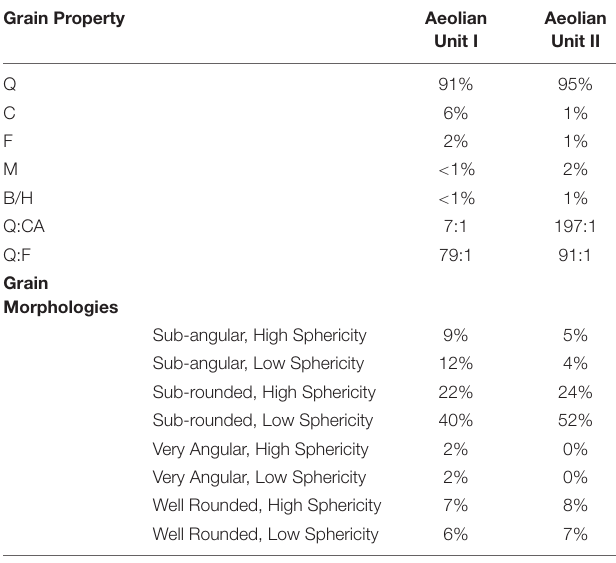
TABLE 3 | Results of micromorphological analysis comparing grain compositions and morphologies between Aeolian Unit I and II facies at Sections U1, U2, GP5, and